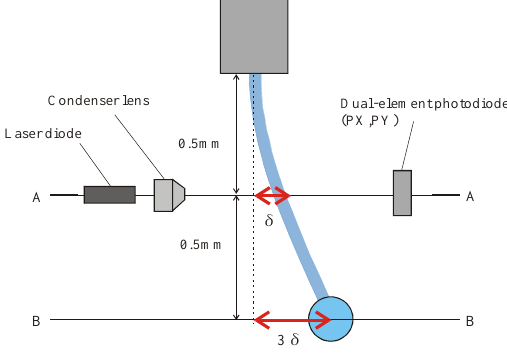
Figure 5. Schematic diagram of the probing system.